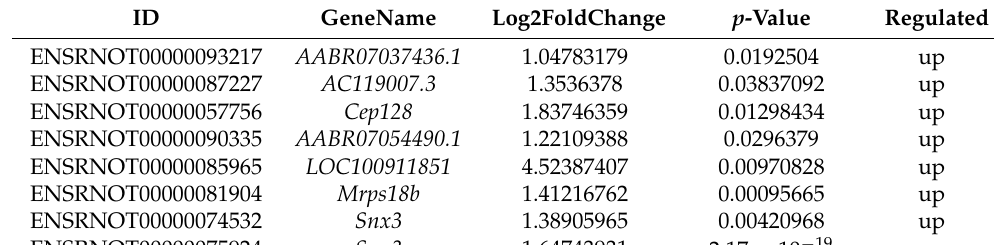
Table 1. The expressions of 8 candidate lncRNAs.